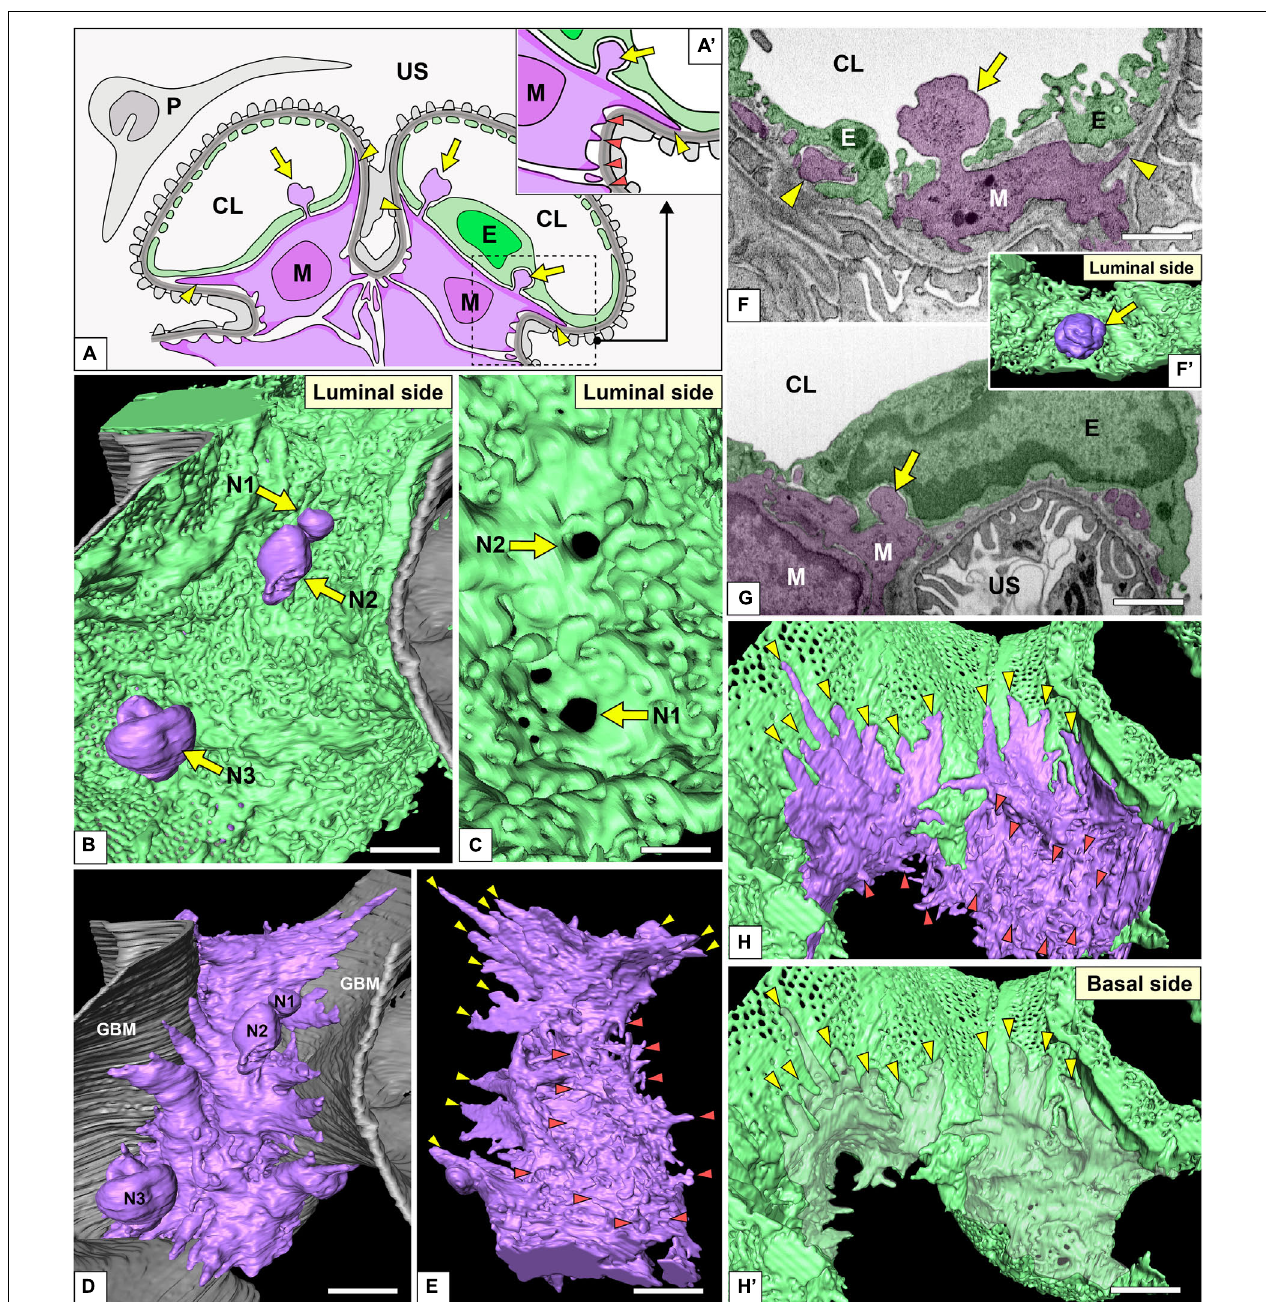
FIGURE 9 | Spatial relationship among glomerular endothelial cells (GEnCs) and mesangial cells. (A,A (cid:48) ) Schematic diagram showing the two-dimensional geometry of GEnCs (green, E), mesangial cells (purple, M), podocytes (gray, P), and the glomerular basement membrane (GBM). The non-adhesive mesangial cell processes (arrows) protrude toward the juxtamesangial region of the GEnC to form the indentation or penetrate it into the capillary lumen. Most of the adhesive mesangial cell processes are spiny cytoplasmic processes and adhere to the GBM at their tips (orange arrowheads in A (cid:48) ). Some adhesive mesangial cell processes exhibit large, tongue-like shapes and are inserted into the narrow angle between the GEnC and GBM (yellow arrowheads in A,A (cid:48) ). (B) Luminal view of three non-adhesive mesangial cell processes (purple, N1–N3) penetrating the green GEnC. Gray layer, GBM. (C) The large holes of GEnCs (arrows) for the penetration of mesangial cell processes, N1 and N2. (D) The spatial relationship between the mesangial cell and GBM. The green GEnC shown in (B) is removed to reveal the mesangial cell processes. (E) The mesangial cells shown in (D) are rotated 180 ◦ to show the spiny mesangial cell processes (orange arrowheads). Some of them develop tongue-like projections (yellow arrowheads). (F,G) Focused-ion beam-scanning electron microscopy (FIB-SEM) images of adhesive (arrowheads) and non-adhesive mesangial cell processes (arrows). (F (cid:48) ) Three-dimensional reconstruction of the non-adhesive process shown in (F) . (H,H (cid:48) ) The impression created by the tongue-like processes against the basal surface of the juxtaglomerular region (yellow arrowheads in H (cid:48) ). CL, capillary lumen; US, urinary space. Scale bar, 2 µ m in (B,D,E,H (cid:48) ) ; 200 nm in (C,F,G) . The reconstructed image of GEnC and mesangial cell (B,E) is also shown in Supplementary Movie 8 .